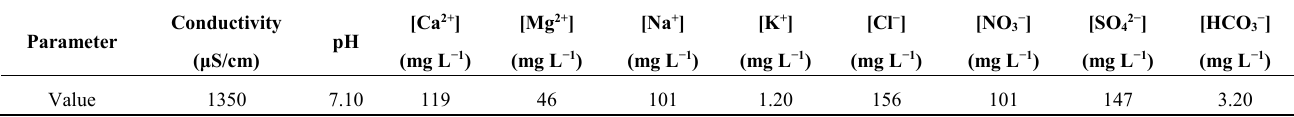
Table 1. Chemical and physical properties of the drinking